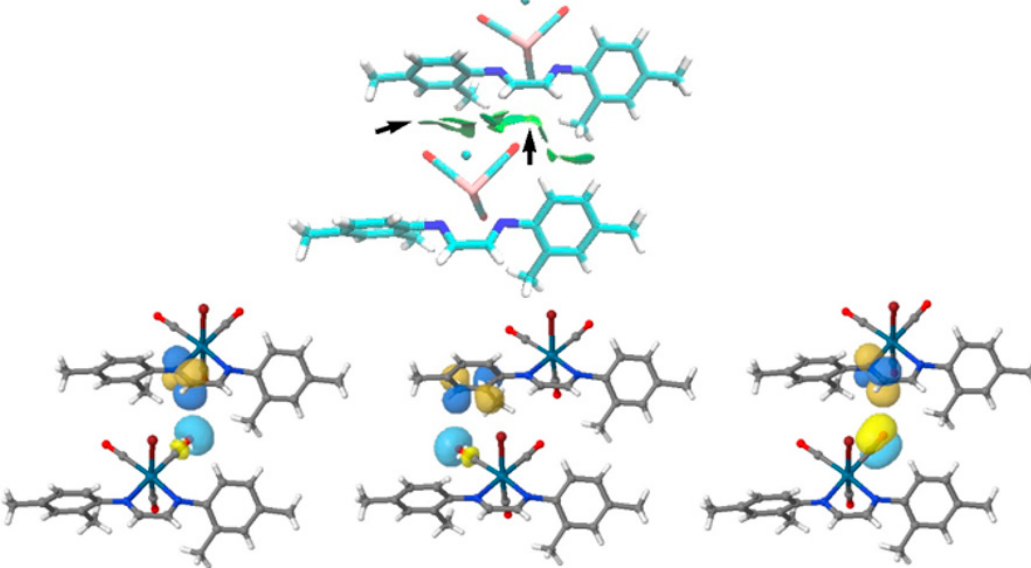
Figure 5. NCI plot of interacting dimer in 1 and the donor–acceptor interacting orbitals from NBO calculations. The area of n ... π * and π ... π * are shown in the NCI plot with arrows.